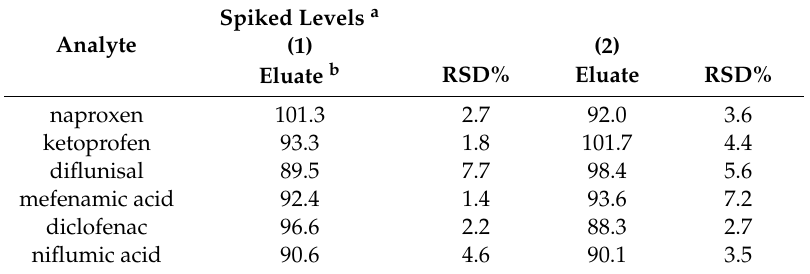
Table 4. Recoveries (%) and RSDs after the WAX based SPE of 500 mL of reservoir water samples at two di ff erent spiked levels. Spiked Levels a Analyte